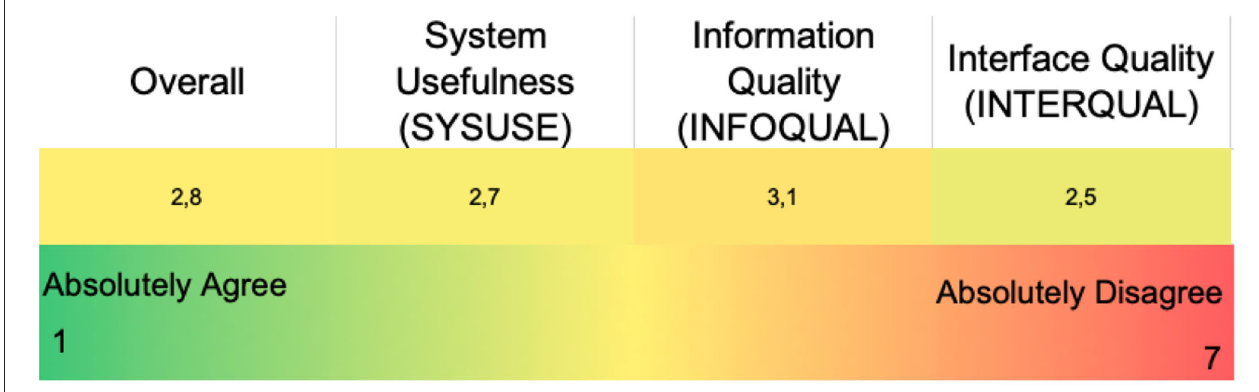
FIGURE 7 | PSSUQ scores for the patient mobile app (overall and